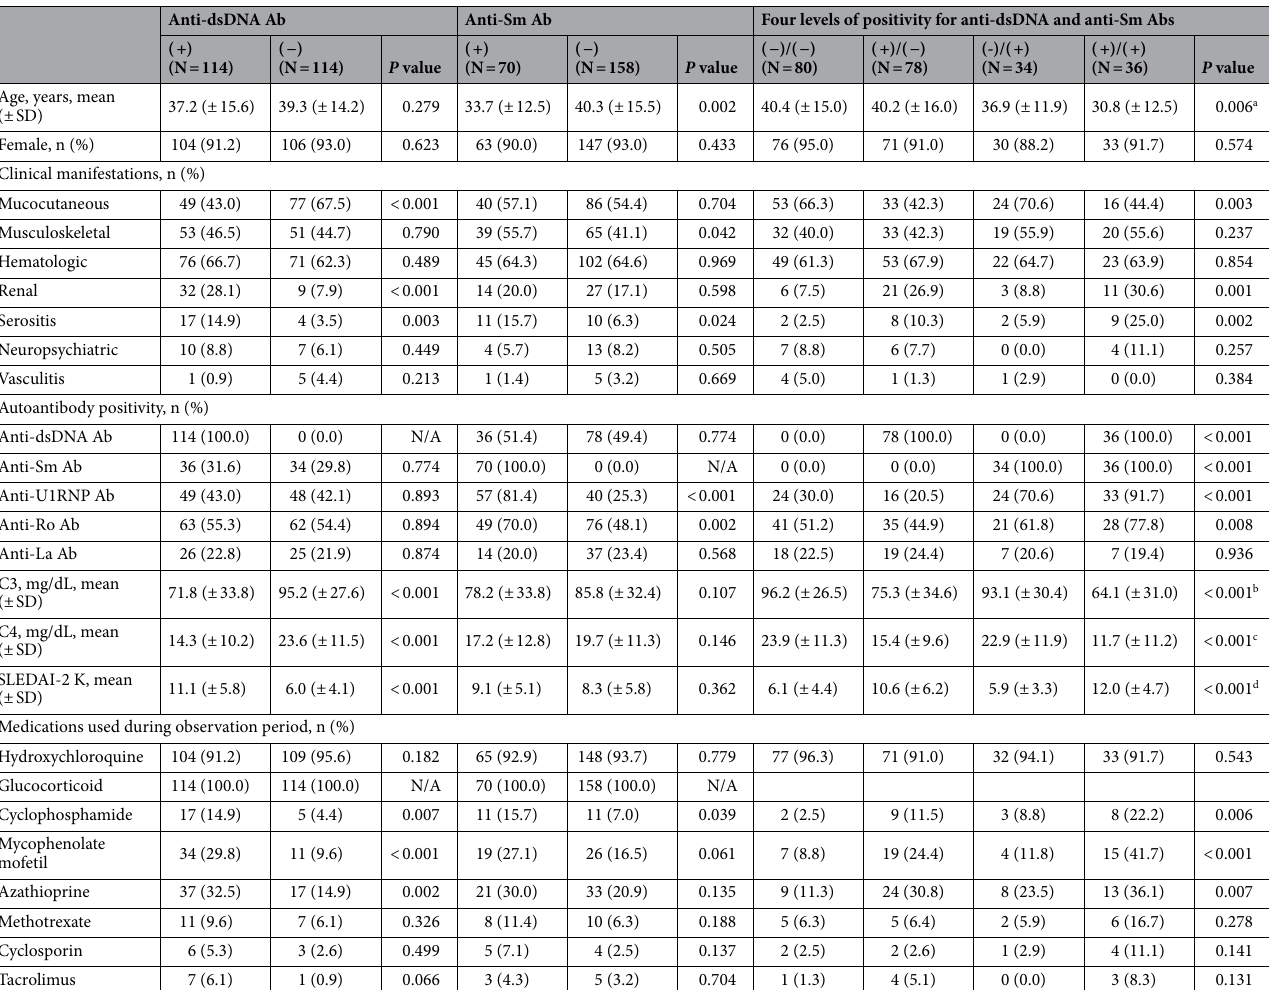
Table 4. Comparison of characteristics according to positivity of anti-dsDNA Ab and anti-Sm Ab. ds double- stranded; Ab antibody; SLEDAI-2 K systemic lupus erythematosus disease activity index 2000. a Significant differences in Bonferroni test: ( −)/( −) versus. ( +)/( +), p = 0.007; and ( +)/( −) versus. ( +)/( +), p = 0.010. b Significant differences in Bonferroni test: ( −)/( −) versus. ( +)/( −), p < 0.001; ( −)/( −) versus. ( +)/( +), p <